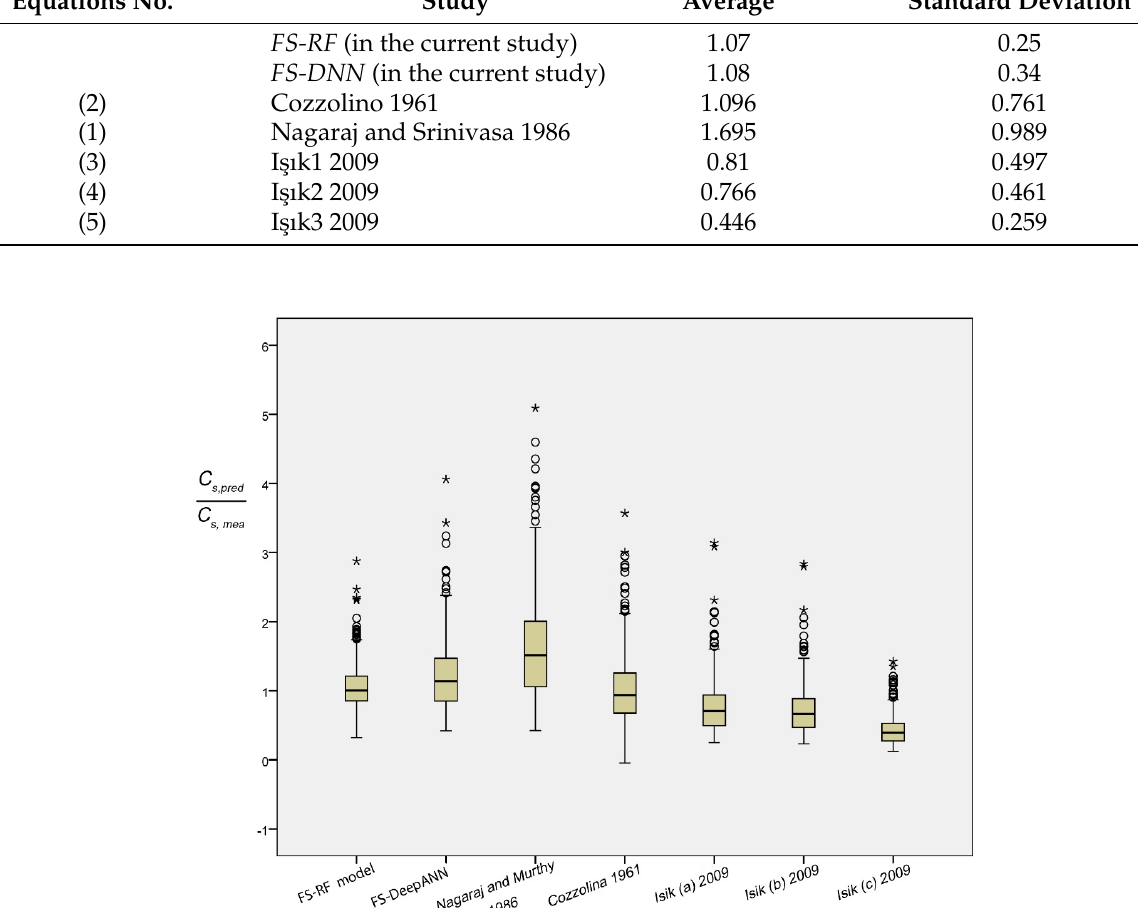
Figure 7. This graphical representation provides an overview of the dispersion and skew- ness of every model. The scattering of the most appropriate FS-RF model appears only to be slightly regular and close to one, and is described by a shorter box than the others. The large box distant from 1, increasing to five in certain models, shows little variation in pre- dicting C s . Data characterized by circles and stars in the figure denote the extreme and extra-extreme value. Table 11. Statistical results of the ratio C s , estimated / C s , measured for some proposed empirical formulae. Table 11. Statistical results of the ratio (cid:1829) (cid:3046),(cid:3032)(cid:3046)(cid:3047)(cid:3036)(cid:3040)(cid:3028)(cid:3047)(cid:3032)(cid:3031) (cid:1829) (cid:3046),(cid:3040)(cid:3032)(cid:3028)(cid:3046)(cid:3048)(cid:3045)(cid:3032)(cid:3031) ⁄ for some proposed empirical formu- Equations No. lae.